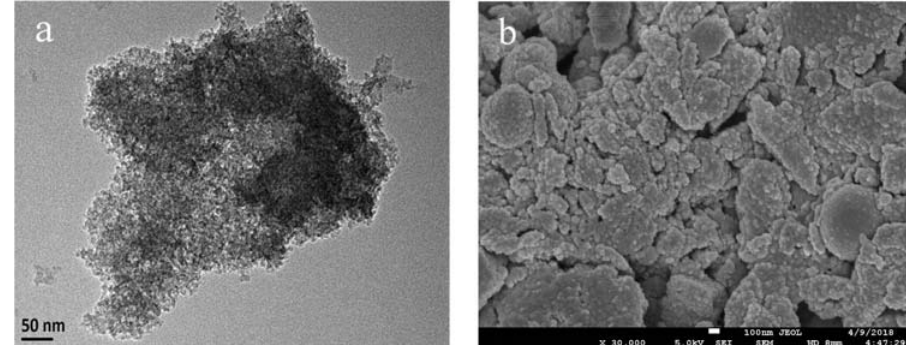
Figure 1: ( a ) TEM of TUD - 1 and ( b ) SEM of TUD - 1.